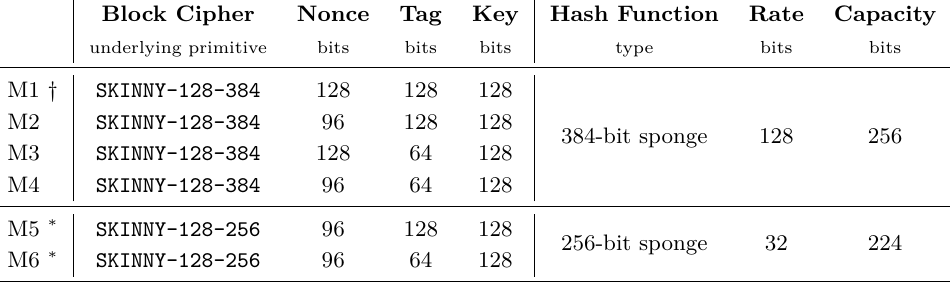
Table 1: Our proposed AEAD schemes and hashing